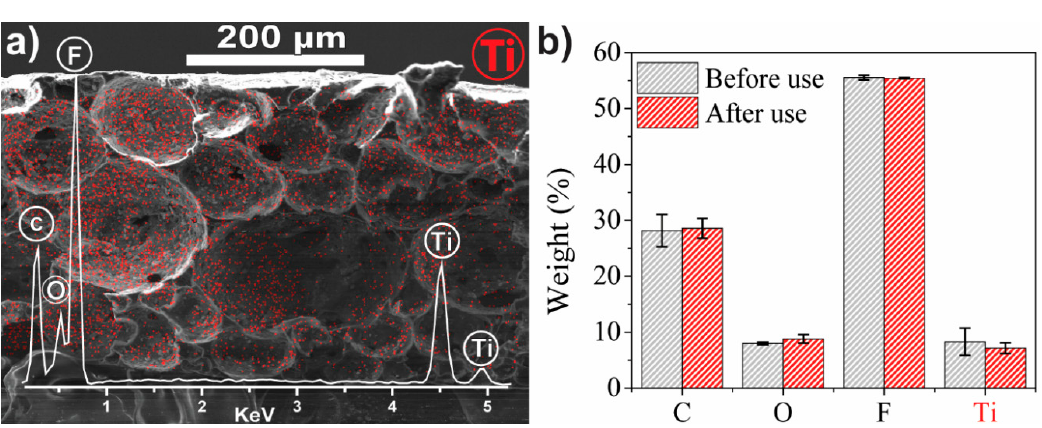
Figure 2. ( a ) SEM-EDX mapping image of the presence and distribution of Ti (red) in the PVDF-TrFE matrix and inset of the EDX spectrum with the identification of the detected elements. ( b ) Elemental percentages of Ti, O, F, and C before and after use.